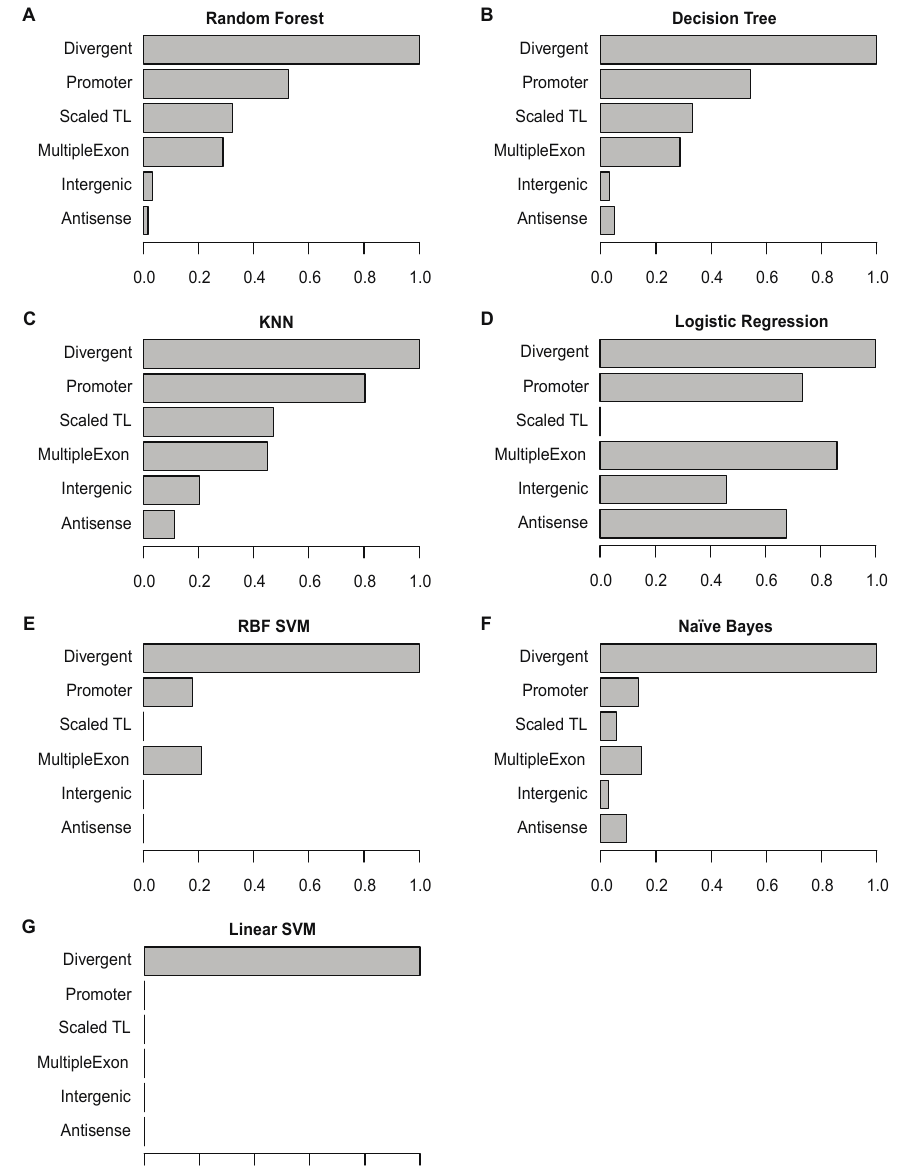
Figure 6. Feature importance for each of the seven final models. Each graph shows the scaled importance scores for each feature for the given model: random forest ( A ), decision tree ( B ), KNN ( C ), logistic regression ( D ), support vector machine (SVM) with RBF kernel ( E ), Naïve Bayes ( F ), and SVM model with linear kernel ( G ) models. For each model, the importance scores of all features were scaled to (0.1) by dividing the original score of the most significant feature (see Section 4).